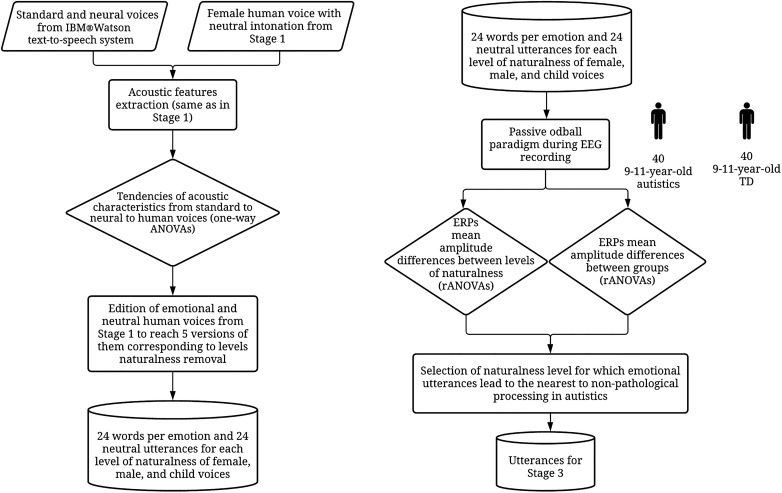
Process of Stage 2. TD, Typically developed.